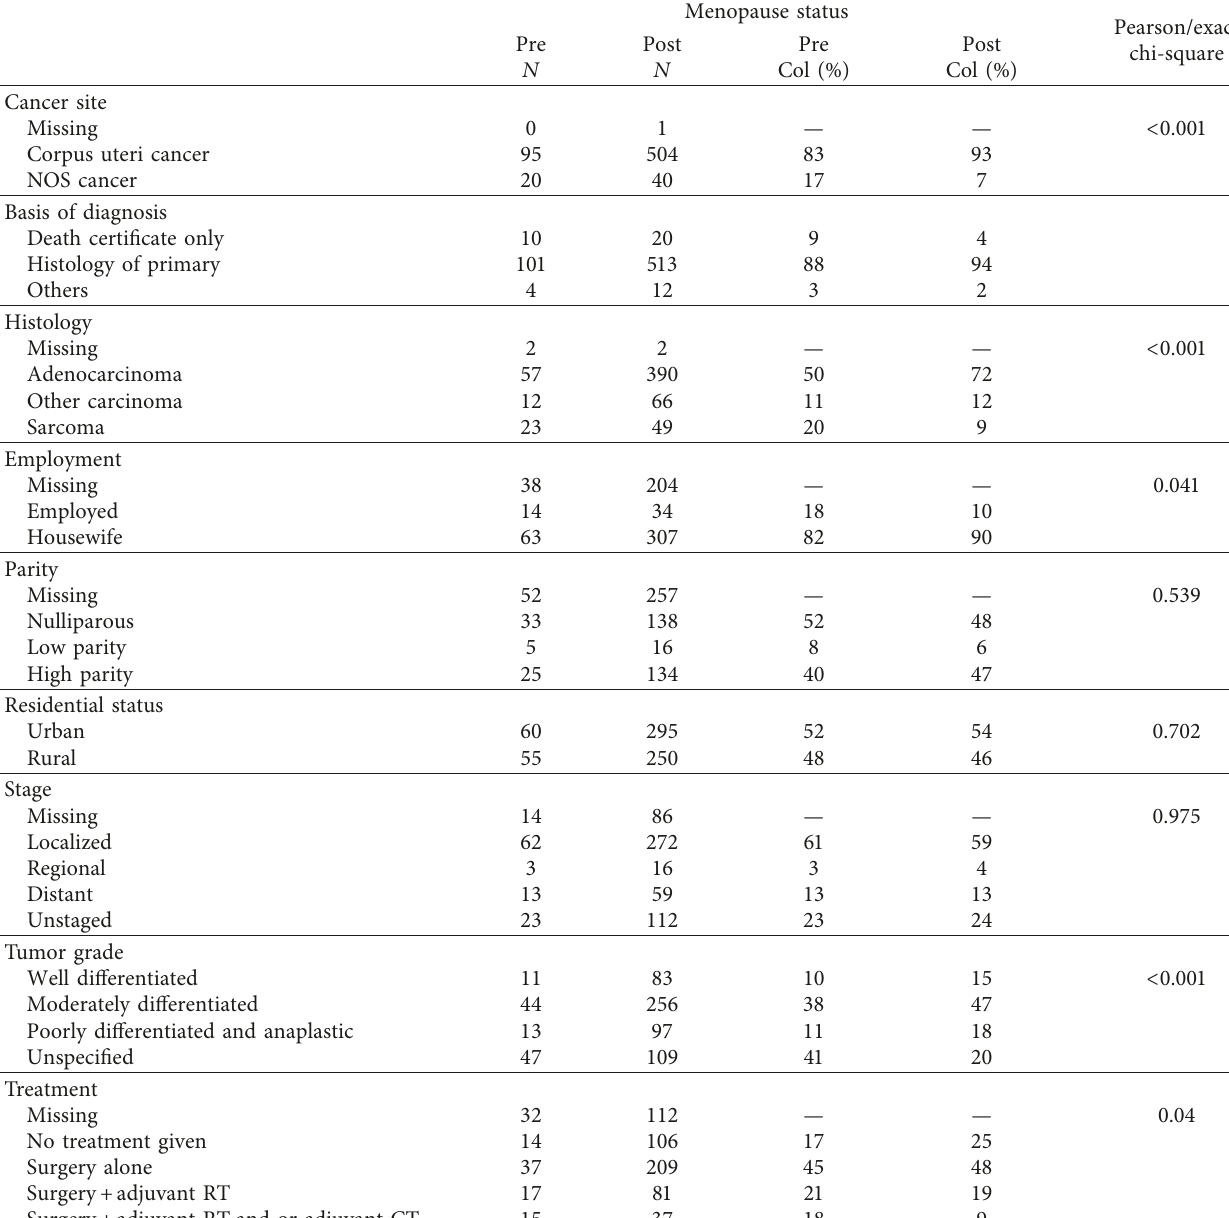
Table 4: The association of clinical characteristics and menopausal status of the uterine cancer cases ( n � 660) in the Gharbiah province, 2010.